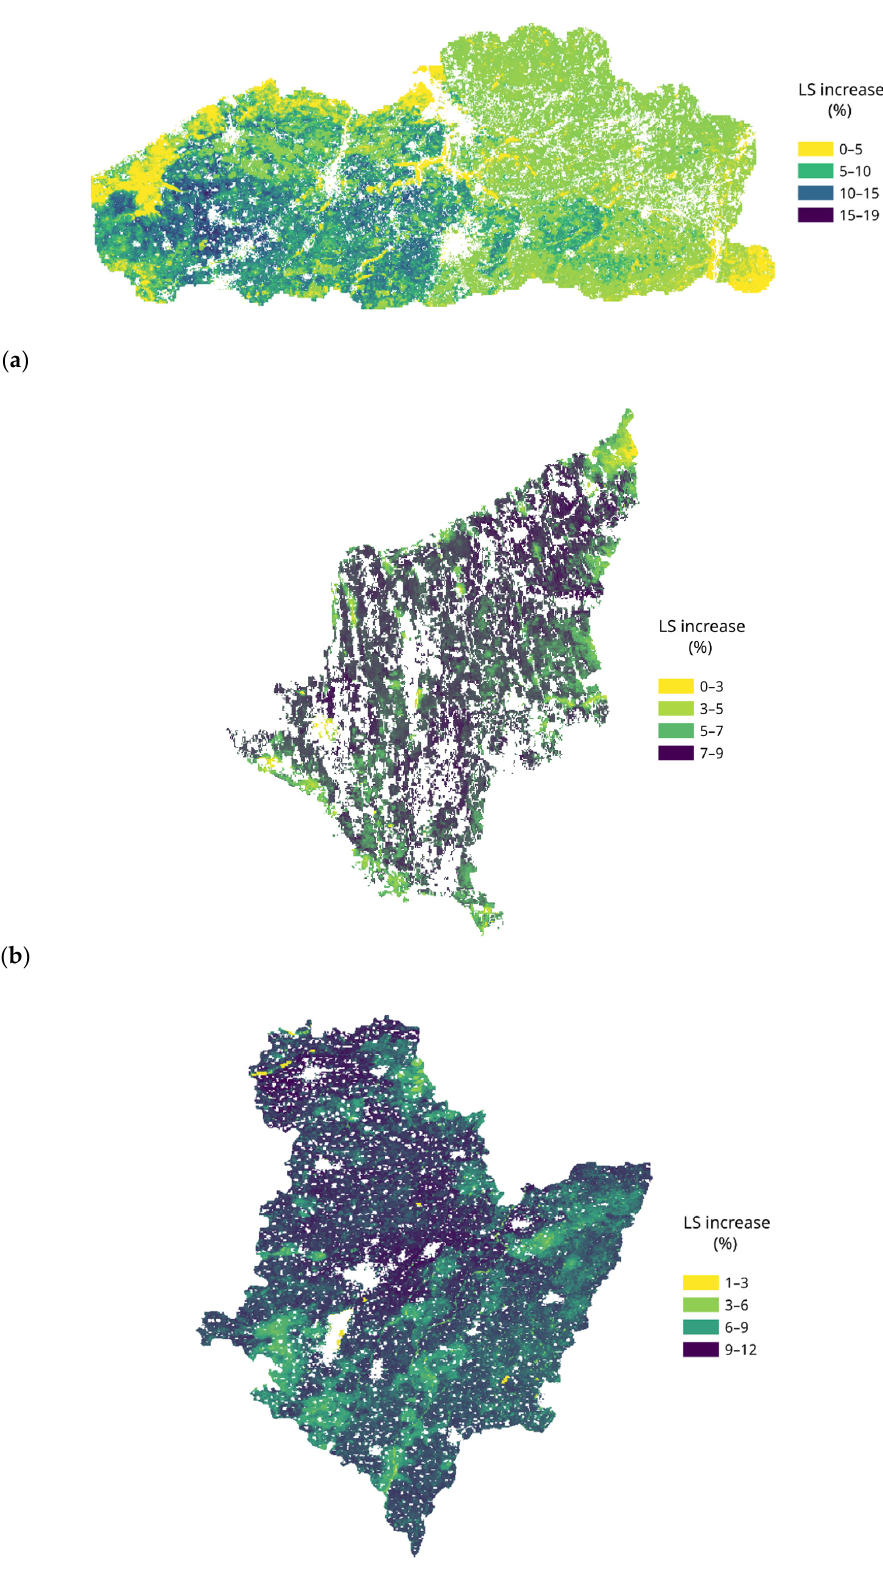
Figure 15. Percentage increase in LS score after the application of the best SICS per site: Crop Residue Management in Flanders ( a ), Cover Crop in Somogy ( b ), and Crop Residue Management in Hengshui ( c